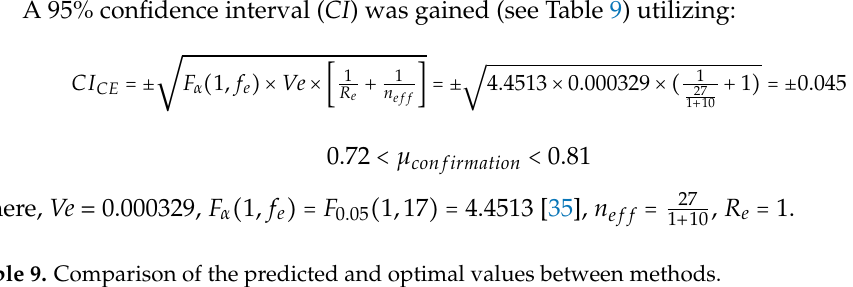
Table 9. Comparison of the predicted and optimal values between methods.